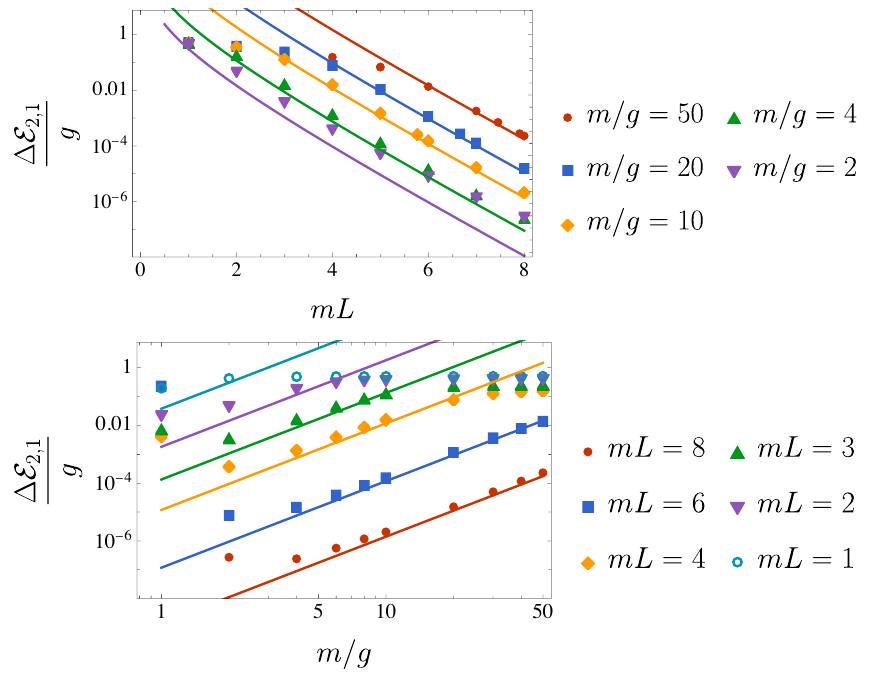
√ x fixed, N → ∞ ) lattice results (dots) versus the between the 2 , 1 /g